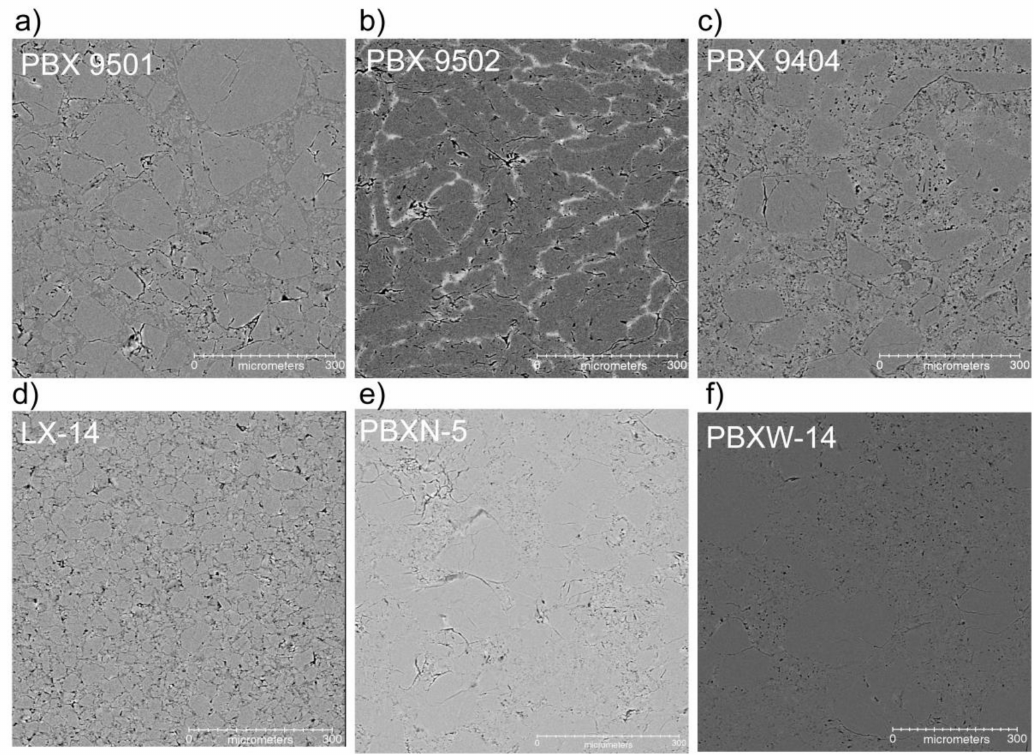
Figure 3. Reconstructed µ CT slice images from the six plastic-bonded explosive materials. PBX 9501 ( a ), PBX 9502 ( b ), PBX 9404 ( c ), LX-14 ( d ), PBXN-5 ( e ), and PBXW-14 ( f ). The images are through the center of the high explosive cylinder and are nearly completely free of all imaging